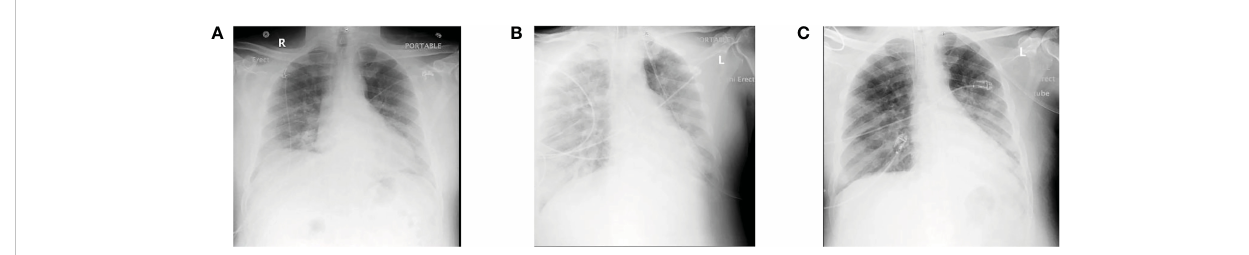
FIGURE 3 (A) Representation of the initial X-ray when the patient was admitted; (B) at day 6 of hospitalization representing severe and unremitting hypoxia and fever, with continued bilateral lung in fi ltration; (C) lung X-ray of cytokine fi ltration therapy at the fi rst day demonstrating continuous in fi ltration with increased aeration with alleviated right lower lobe consolidation. Reproduced with permission from